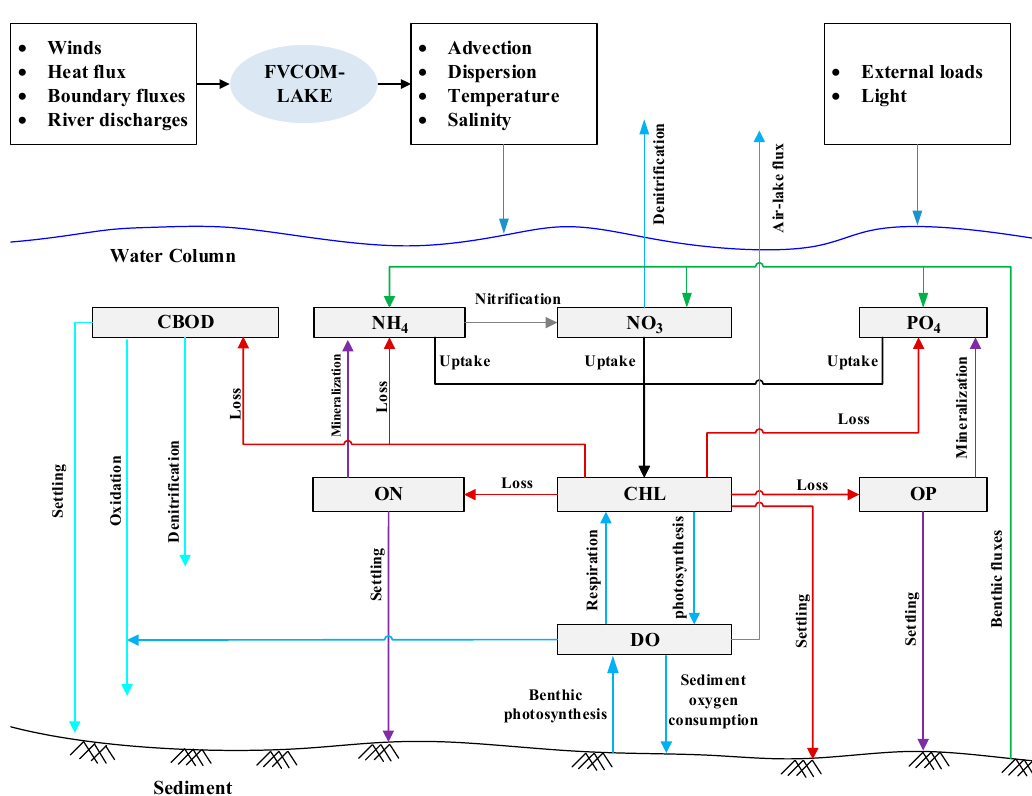
Figure 1. Conceptual framework of the WASP water quality model.